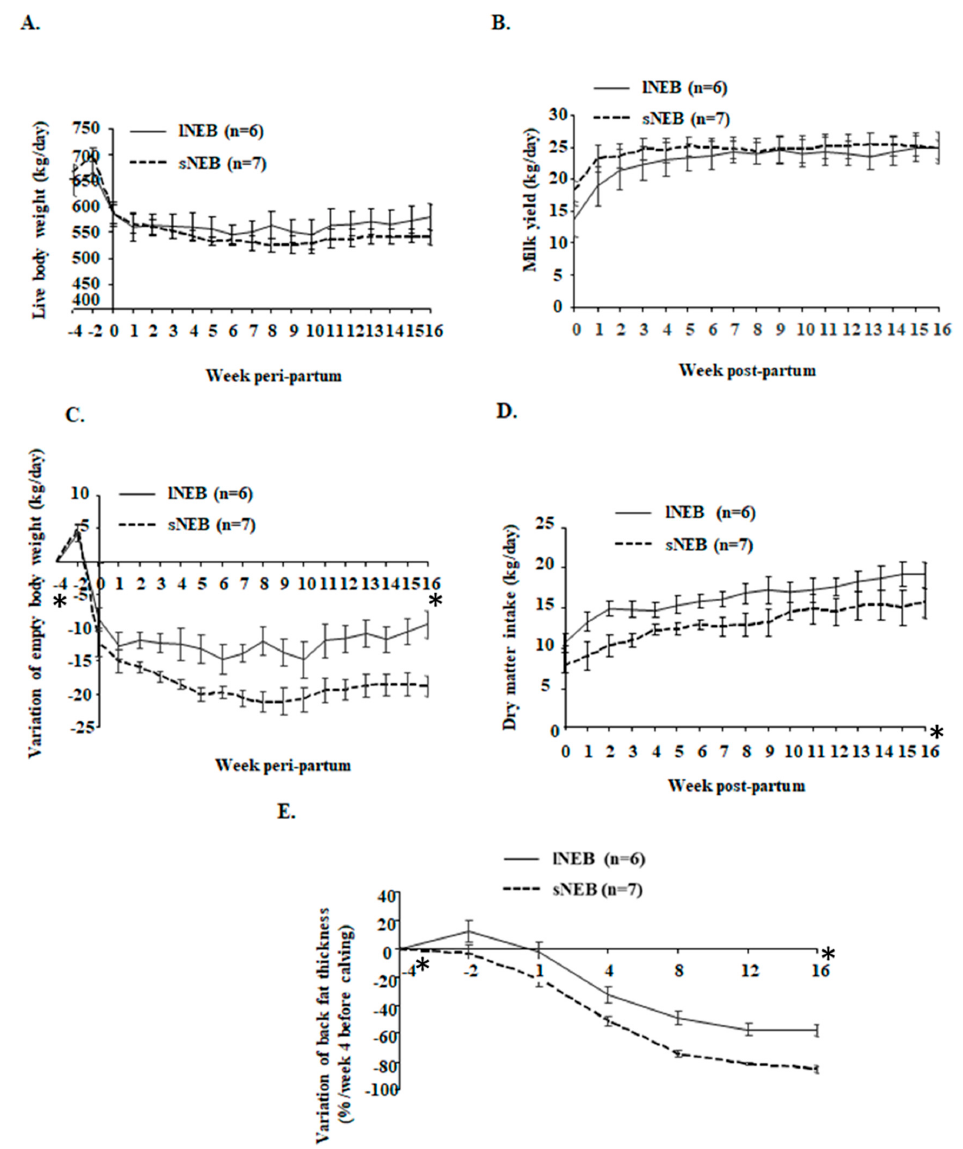
Figure 2. Live body weight ( A ), milk yield ( B ), variation of empty body weight ( C ), dry matter intake ( D ), and variation of backfat thickness ( E ) in Holstein cows with lNEB ( n = 6) and sNEB ( n = 7) at week 4 before calving and week 16 after calving. Results are presented as LSmeans ± SEM. Asterisks (*) are representative of statistically significant ( p < 0.05) differences among LSmeans of the two groups. LSmeans, least square means; SEM, standard error mean.